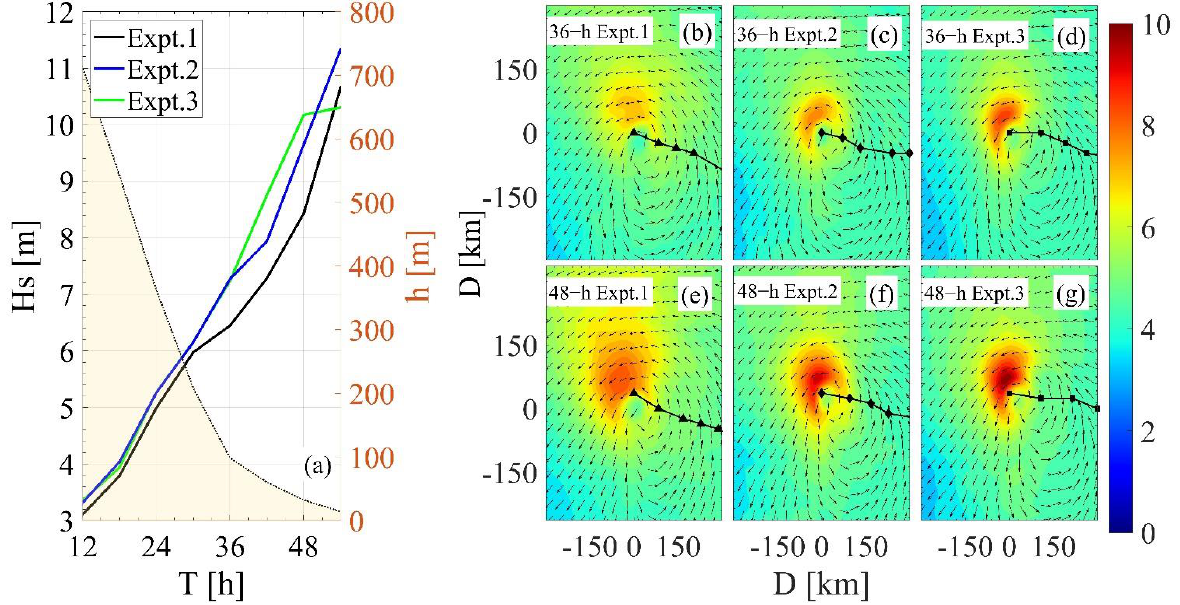
Figure 7. ( a ) The maximum significant wave height (Hs) with the simulation time for the Expt.1, Expt.2, and Expt.3. The border of the shadow area indicates the local water depth around the TC center of Expt.1. ( b – d ) The spatial distributions of Hs with the 6 h TC tracks (black line with the triangle, diamond, and square markers) after 36h simulation for Expt.1, Expt.2, and Expt.3, respectively. ( e – g ) The spatial distributions of Hs with the 6 h TC tracks (black line with the triangle, diamond, and square markers) after 48h simulation for Expt.1, Expt.2, and Expt.3, respectively. Note, the tracks of TC are from the right to the left following the black line. Figure 7b–g shows the spatial distributions of the maximum Hs in Expt.1, Expt.2, and Expt.3 after 36 h, and 48 h simulations, respectively. As we located this idealized TC sys- tem in the Northern Hemisphere, maximum Hs is observed in the right front quadrant of the TC track. This is because, in the right front quadrant of the TC track, the wave direction of propagation of locally generated wind sea is consistent with the propagation of (young) swell, which does not occur in other quadrants (as demonstrated in Figure 3 of [44]). In agreement with Figure 7a, sea spray leads indirectly to the enhancement of Hs after both 36 h and 48 h simulations. The increase in maximum Hs is greater in Expt.3 than in Expt.2, highlighting the critical differences in sea spray parameterizations on ocean surface wave fields through sea spray impacts on the wind fields. In comparison to the local wave height, sea spray has a negligible effect on the direction of the waves (see Figure 7b–g). 3.4. Impacts on the SST Figure 8a shows the minimum SST variation with the model simulation time for Expt.1, Expt.2, and Expt.3. The SST is expected to decrease during the passage of the TC system as deep cold water rises to the ocean surface as a result of turbulent mixing and upwelling. Compared with the minimum SST in Expt.1, the minimum SST is reduced by up to 0.2 °C (0.8%) and 0.15 °C (0.6%) in Expt.2 and Expt.3, respectively. This is a direct result of the sea-spray-induced intensification of the TC system, which in turn positively contributes to the vertical turbulent mixing over the upper ocean. Note, this is in line with other studies which suggest that sea spray strengthens the SST cooling during TC passing [18,29,43]. To further explore the impacts of sea spray on the SST, the spatial distributions of SST during the TC passing are shown in Figure 8b–g. We notice that areas where the SST is reduced are located on the right side of the TC track. This rightward difference is caused by the acceleration of inertial currents due to the rotation of the wind stress vector. Including sea spray physics decreases the minimum SST during the TC passing and ex- pands the surface area of minimum SST in the wake of the TC system. Additionally, we